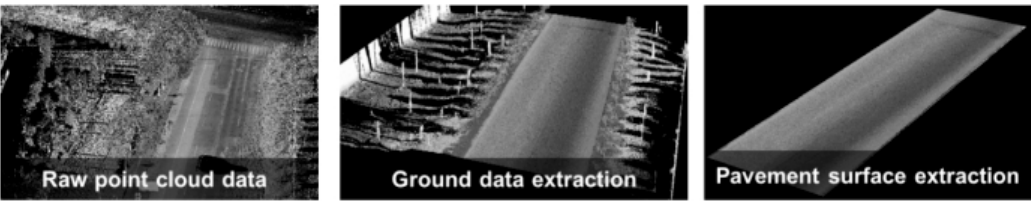
Figure 2. Steps of the pavement region extraction.